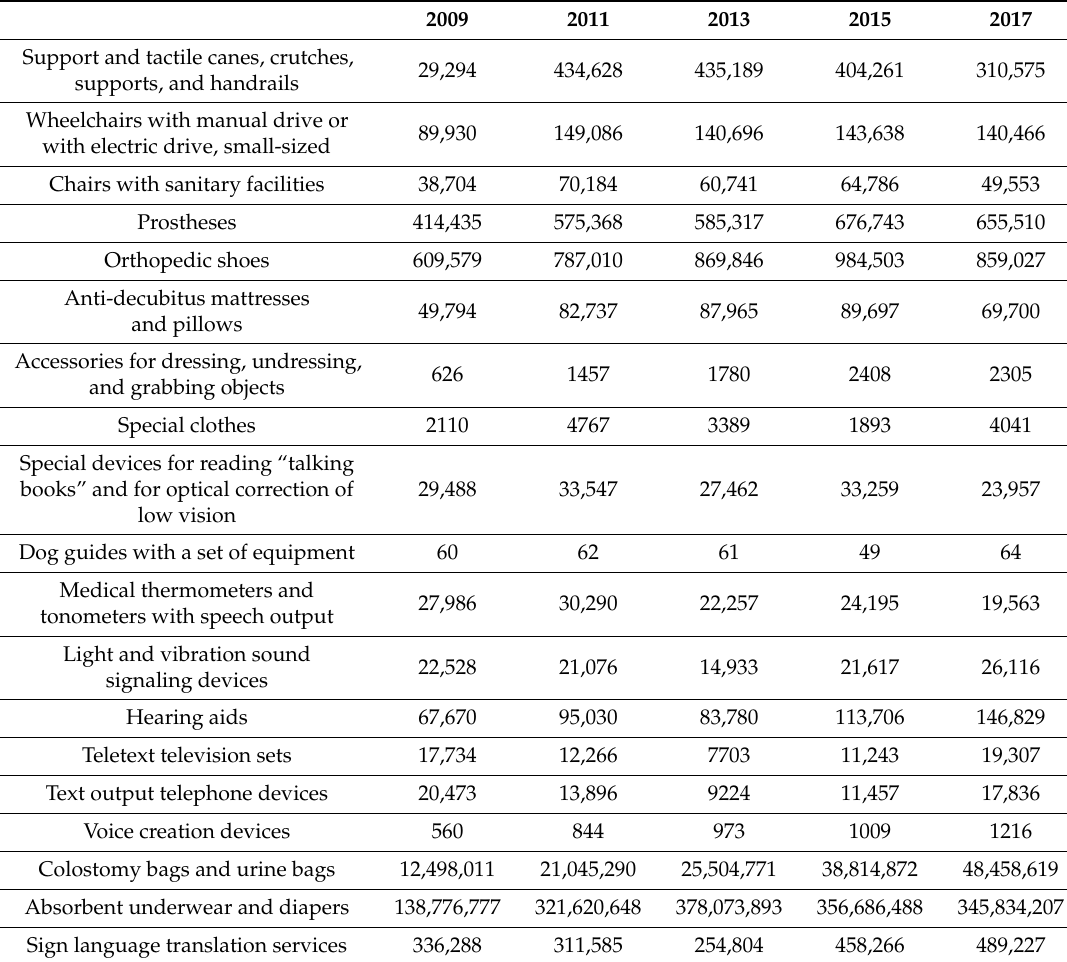
Table 1. Information on technical means of rehabilitation and prosthetic and orthopedic products that the State provides to people with disabilities (pieces) 1